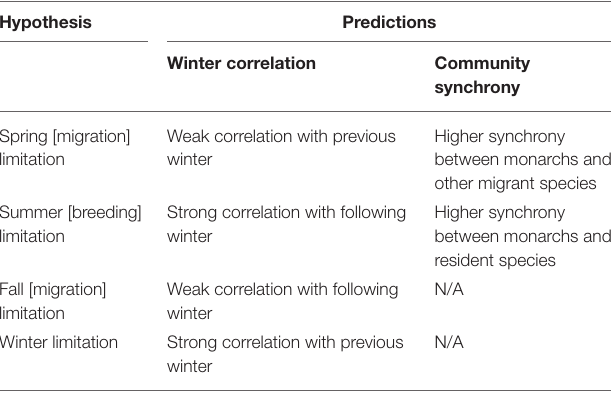
TABLE 1 | Competing hypotheses testing when during the annual cycle monarch butterfly populations in Canada are most limited. Hypothesis